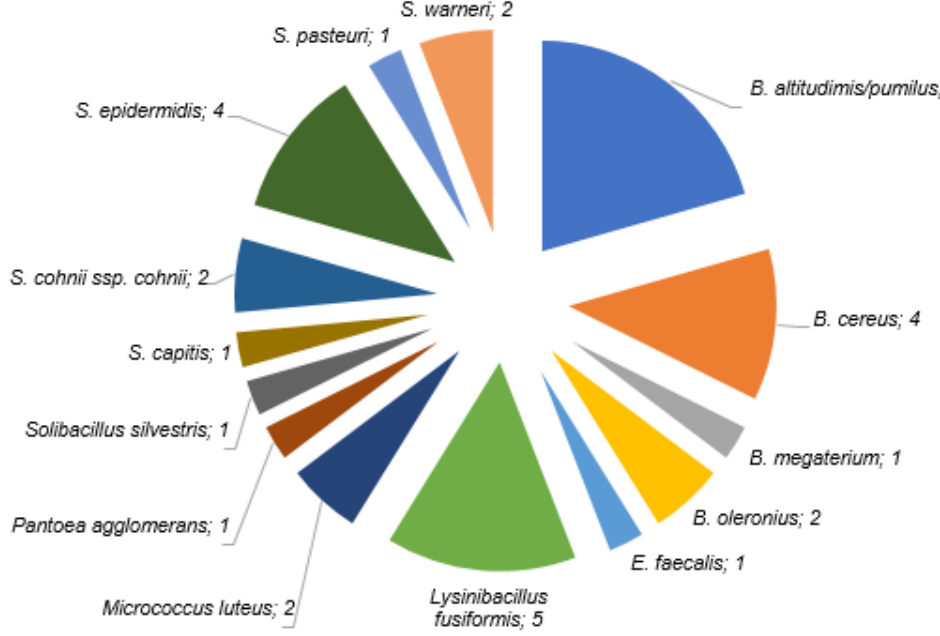
Figure 2. Prevalence of microorganisms isolated from bee pollen samples ( n = 13). Numbers indicate the